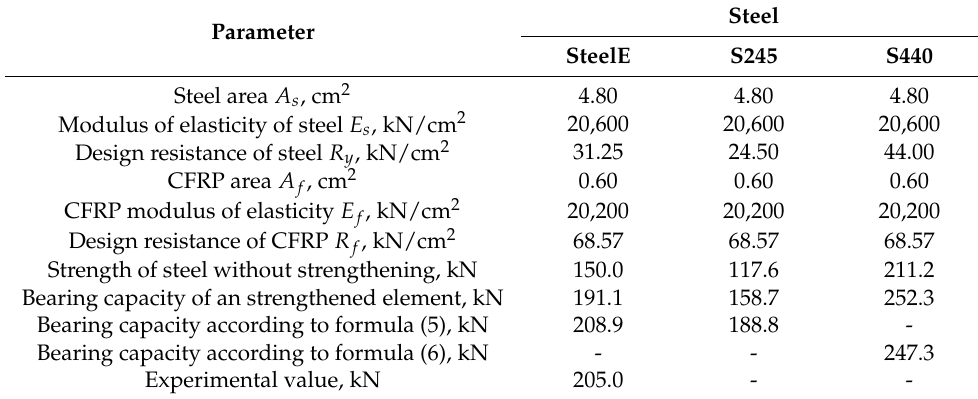
Table 6. Calculation of the bearing capacity of strengthened